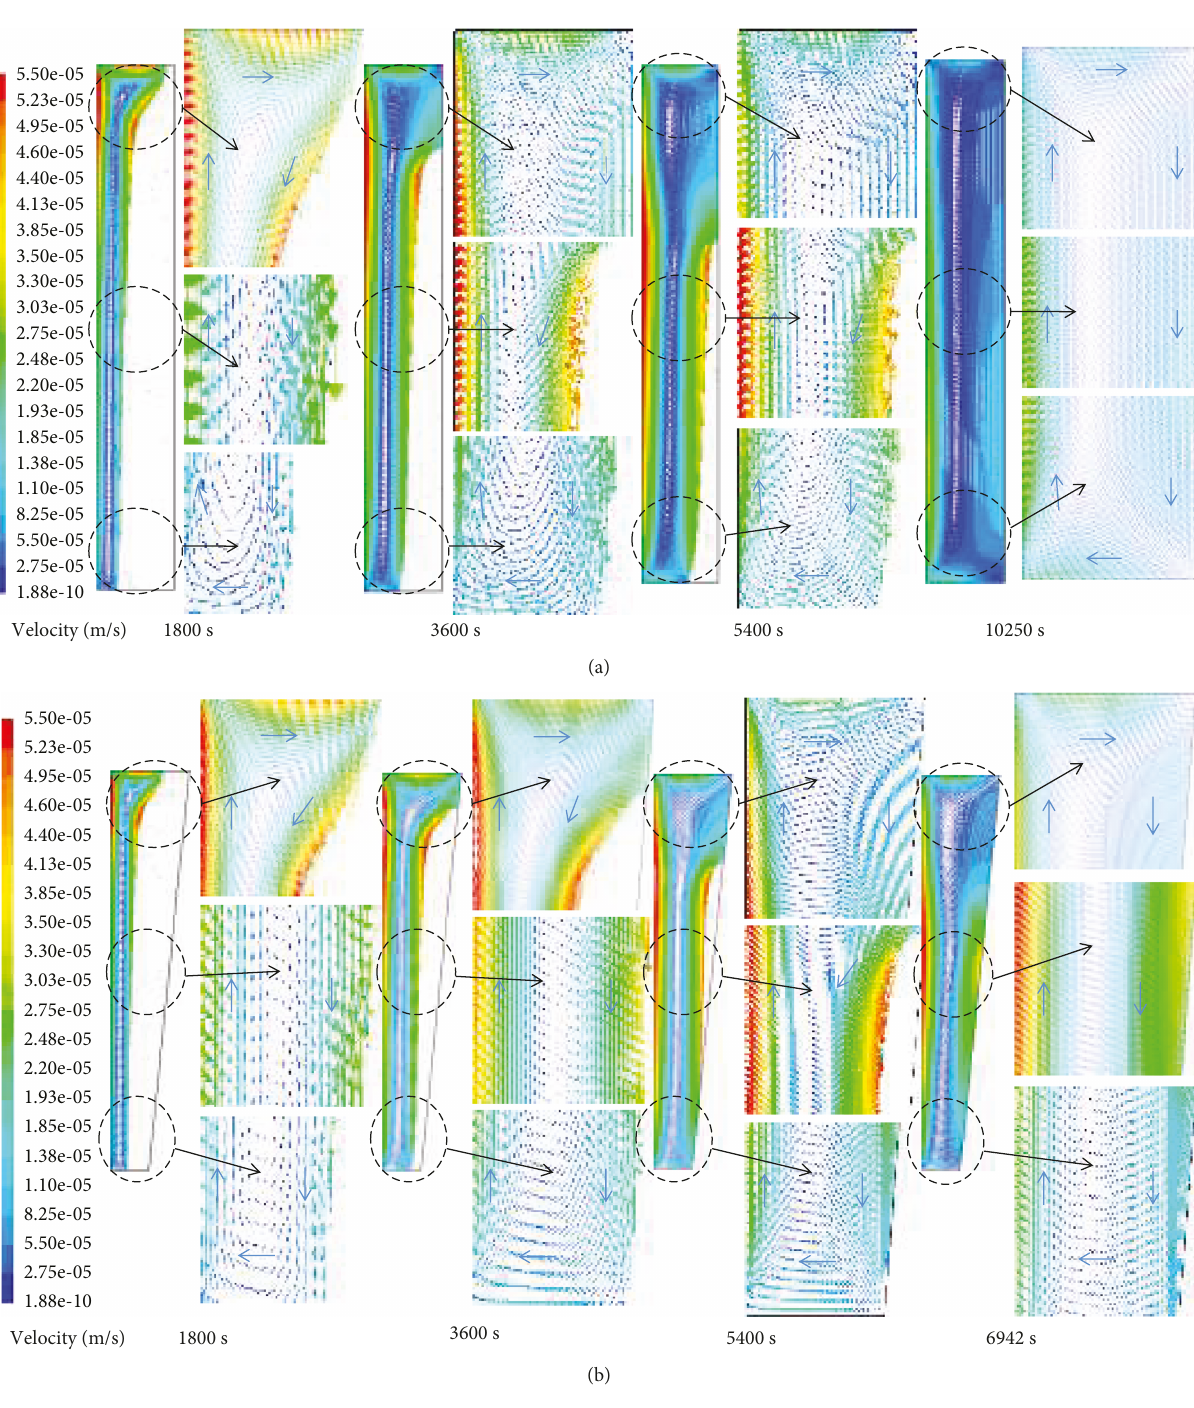
Figure 4: The simulated liquid PCM velocity fi eld with cylindrical (a) and truncated cone (b) TES unit during the melting